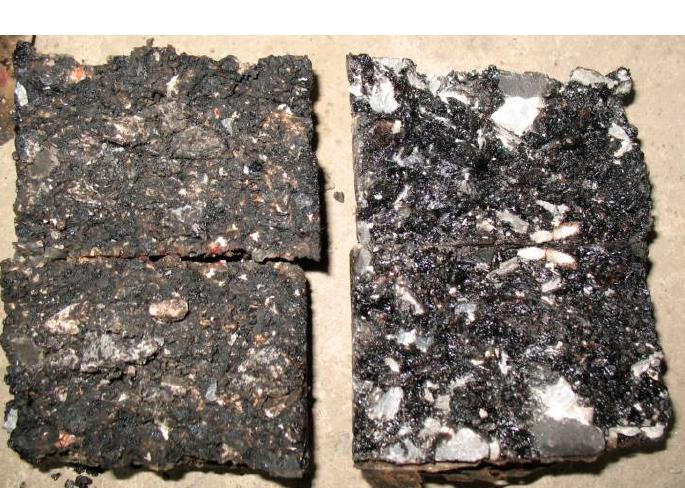
Figure 8. Cleavage face ratio of emulsified asphalt mixture specimen and thermoplastic specimen.